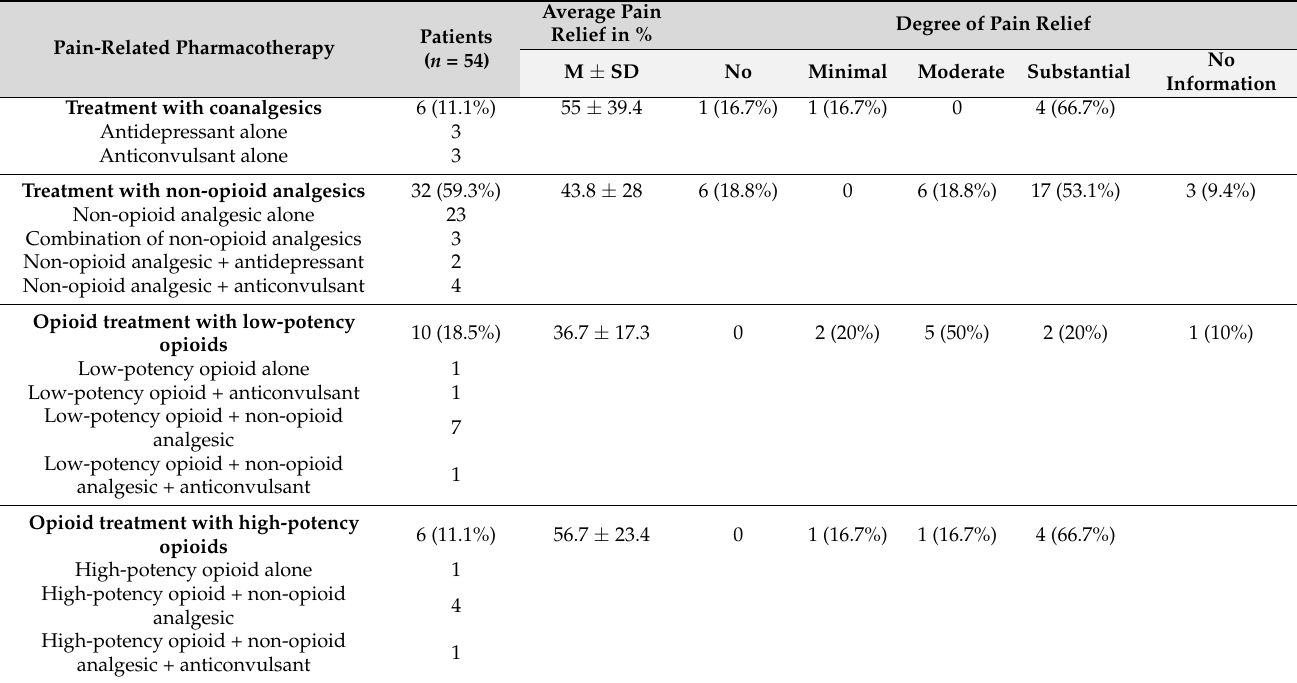
Table 3. Pain-related pharmacotherapy considering drug combinations in the 54 pain patients with pain medication. The patients’ perception of medication-related pain relief is presented as an average value and in terms of clinically relevant degrees of pain relief for the respective type of medication (no pain relief: <10%; minimal pain relief: ≥ 10 and <30%; moderate pain relief: ≥ 30%; substantial pain relief ≥ 50%). Values are given as mean ± SD or number of patients (%), as